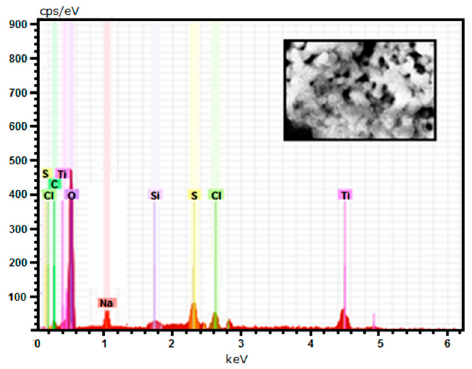
Figure 6. Energy dispersive X-ray (EDX) spectra of S–TiO 2 structures related to the onset selected area (800 nm × 500 nm) .